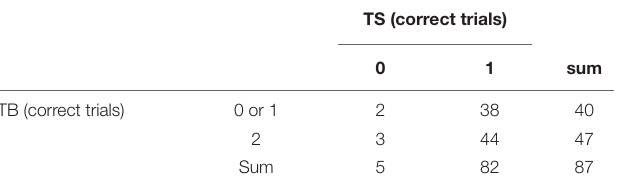
TABLE 2 | Contingency between TB and TS task